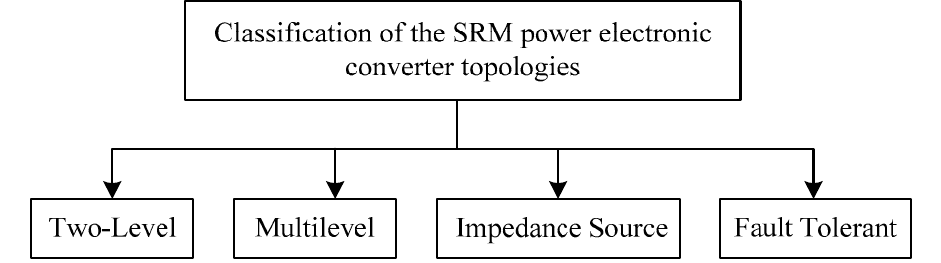
Figure 1. Classification of the Switched Reluctance Machine (SRM) power electronic converter topologies.